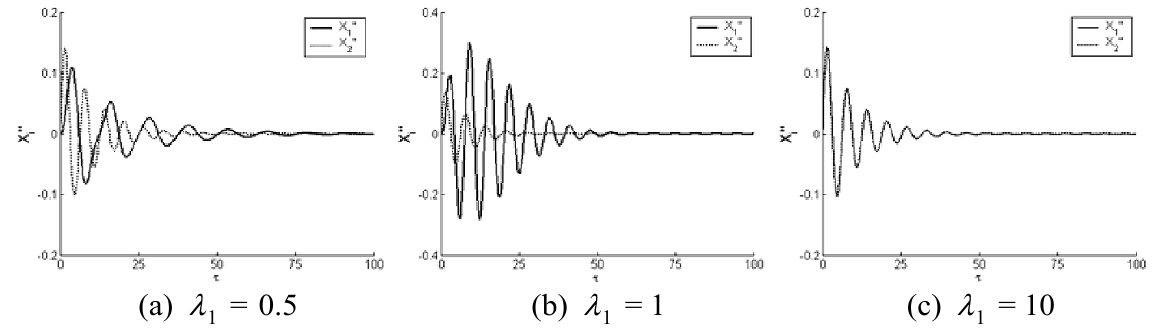
(cid:1)(cid:1) = 0 . 5 , 0 m